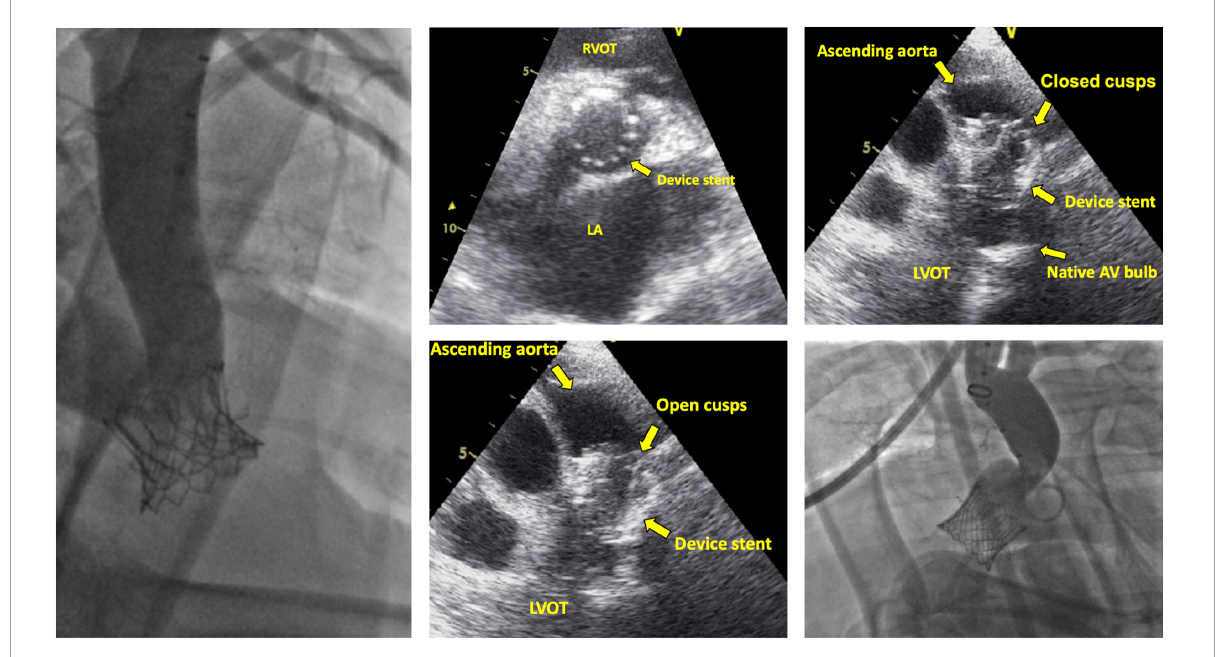
FIGURE4 Fluoroscopy and echocardiography images of the implanted prosthesis.